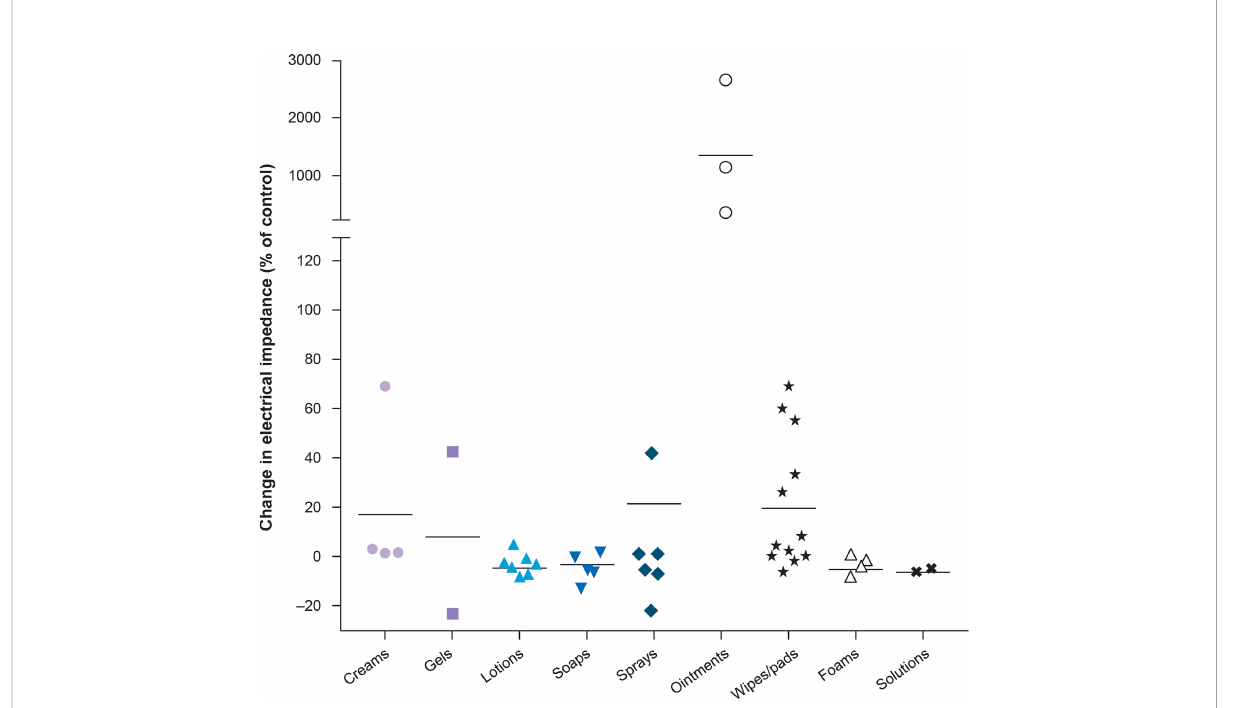
FIGURE 3 Topical agents tested with TTFields therapy on the scalp (25). Horizontal bars represent the mean for each category. Copyright Lacouture ME et al. Front Oncol 2020. Adapted and reproduced under the terms of the Creative Commons Attribution License (CC